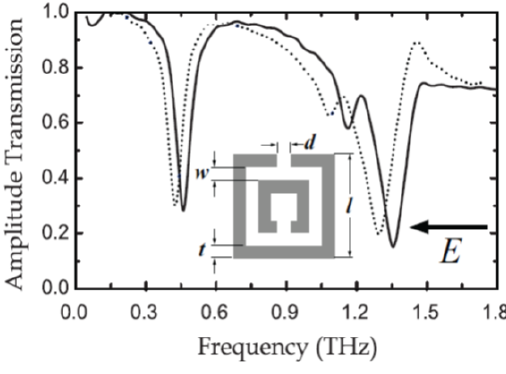
Figure 9. Frequency-dependent amplitude transmission of a double SRR metamaterial without (solid curves) and with (dotted curves) photoresist overlayers of 16 μ m thickness